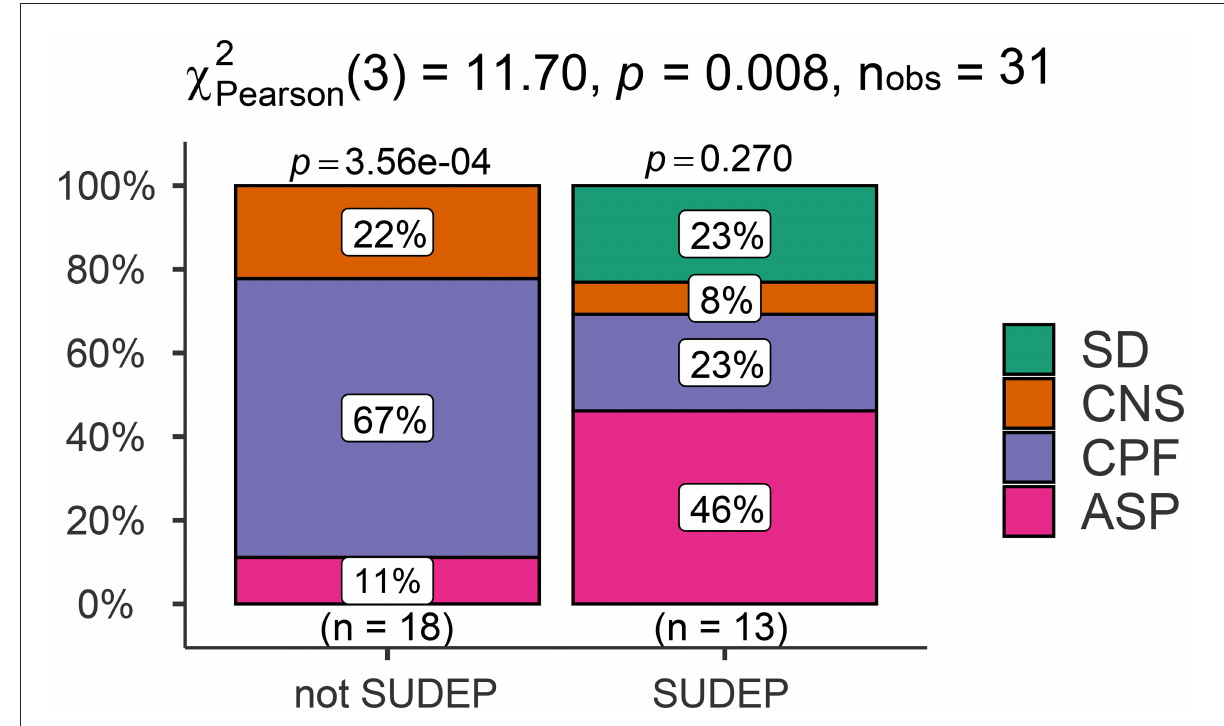
FIGURE6 Comparison of the cause of death classification results in the SUDEP and not-SUDEP